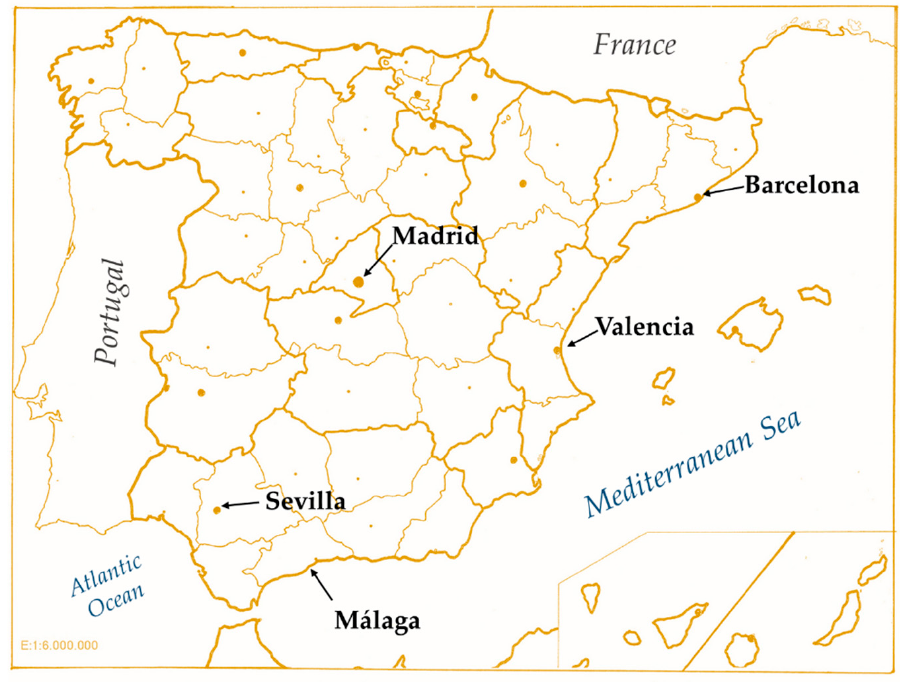
Figure 1. Map representing the localization of the sampled cities within Spain.